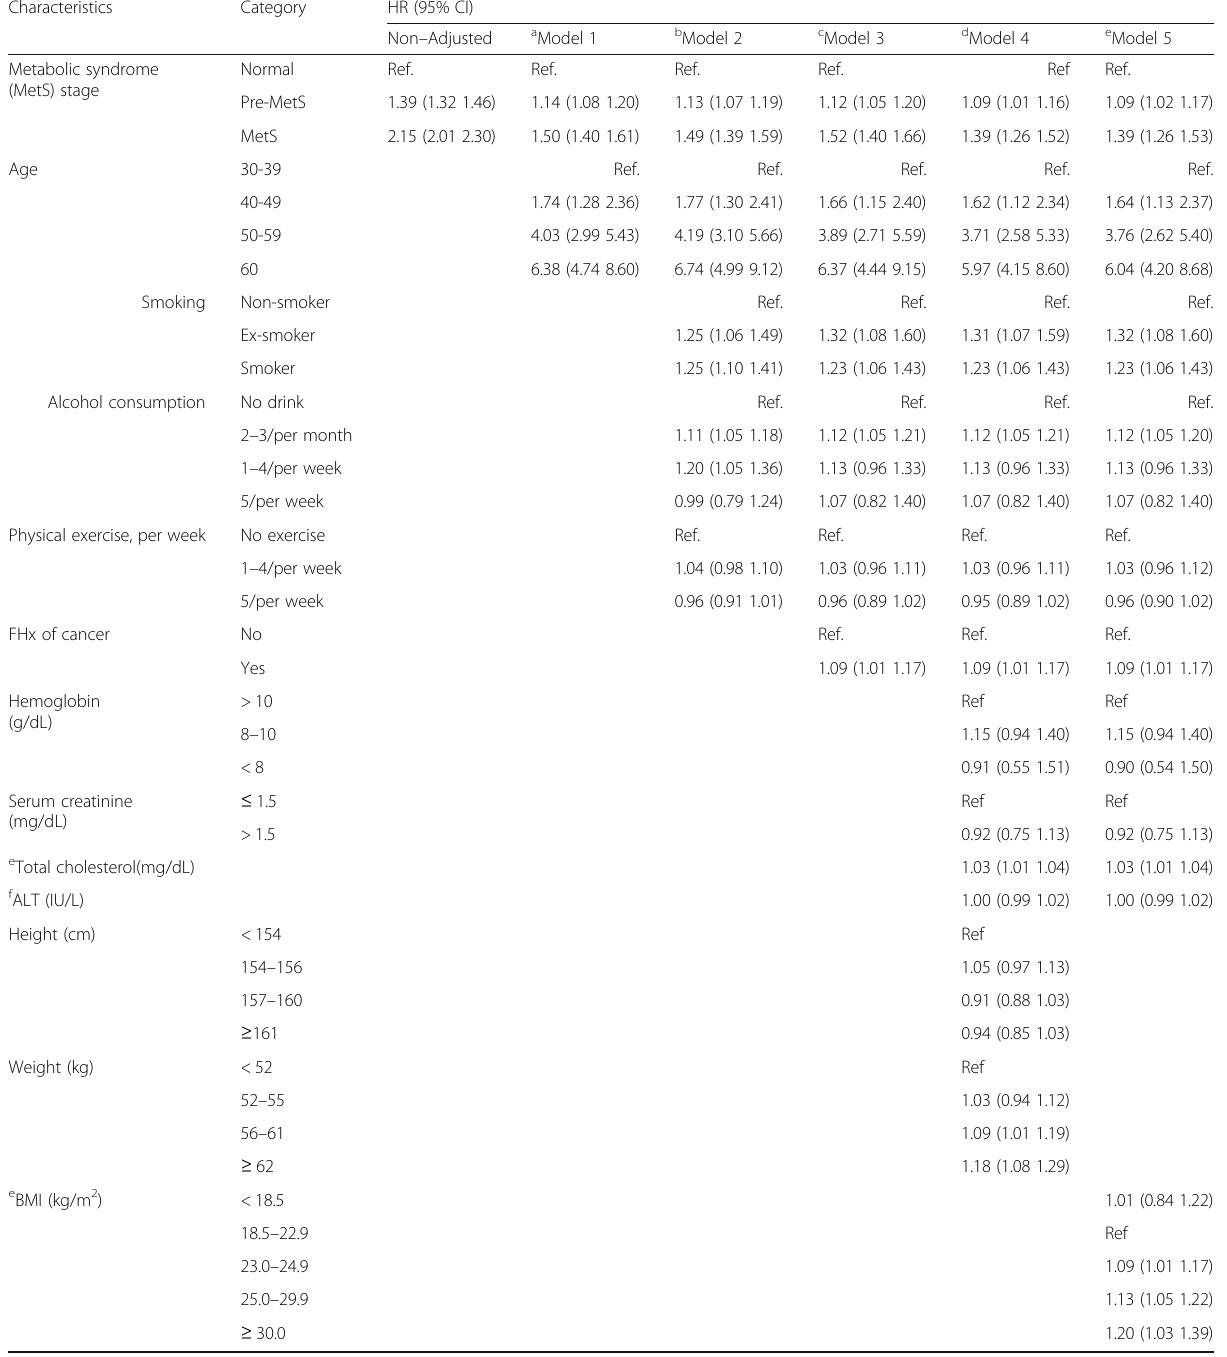
Table 4 Hazard ratios of the cumulative incidence rate of colorectal cancer according to the progression of metabolic syndrome in women